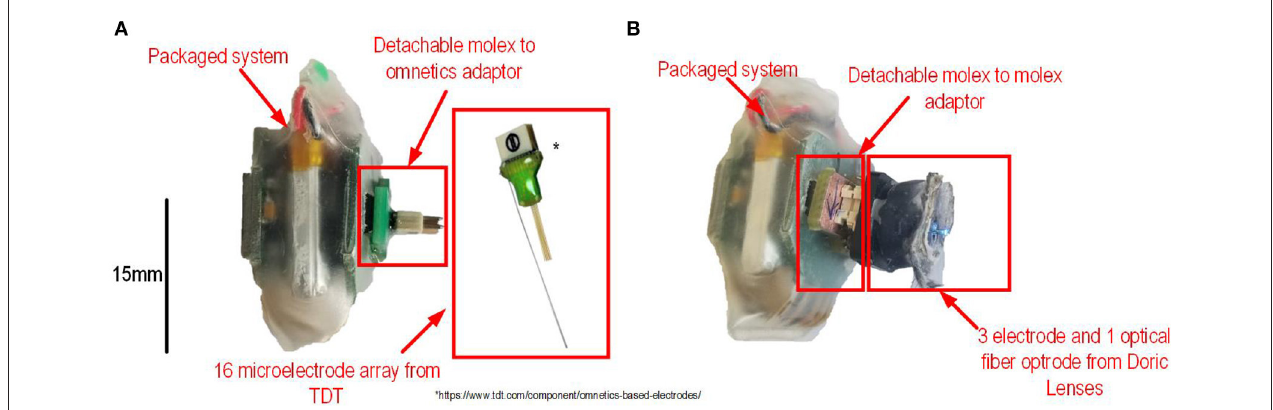
FIGURE 4 | (A) Packaged system connected to a Molex to Omnetics adaptor, a 16 channels microelectrode array and a ground wire. (B) Packaged system connected to a Molex to Molex adaptor and a three electrodes and 1 optical fiber optrode from Doric Lenses